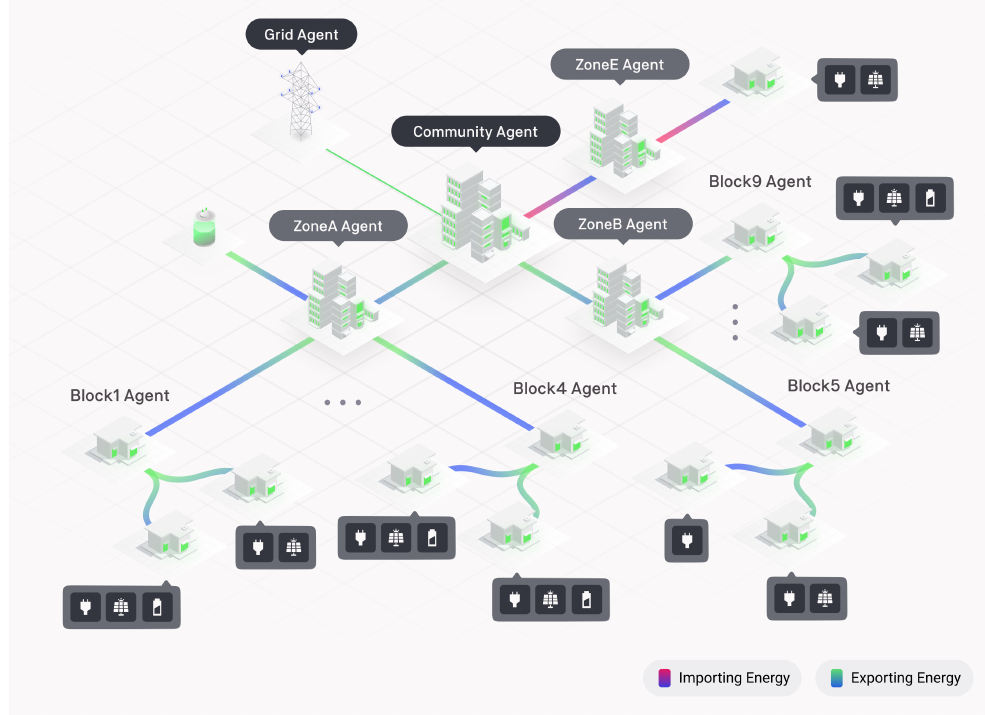
Figure 4. Hierarchical community as a multi-layer, hierarchical, agent-based